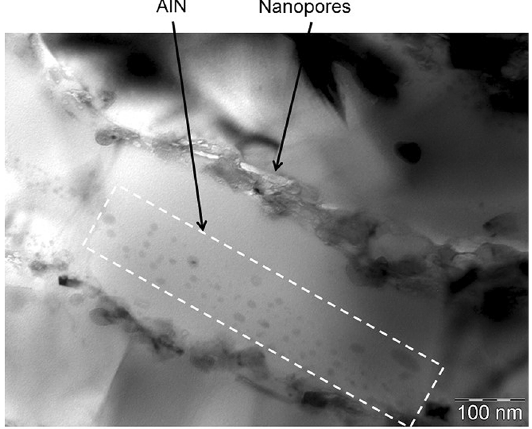
Figure 12. TEM image showing AIN and nanopores in the cryomilled sample degassed at 350 °C for 20 h. The sintering was carried out at 525 °C and 60